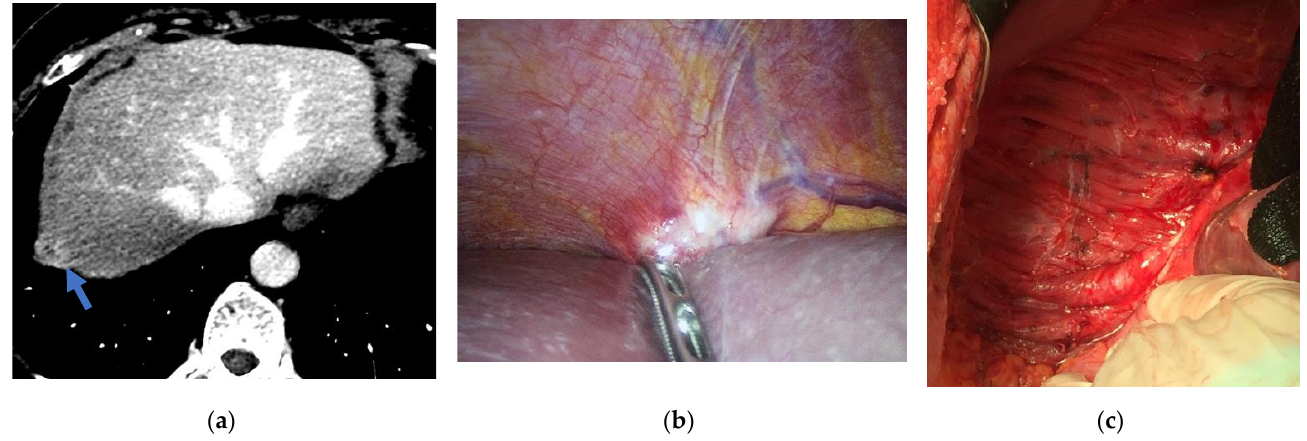
Figure 2. Female patient with peritoneal metastases from ovarian cancer: ( a ) CT of the abdomen show-